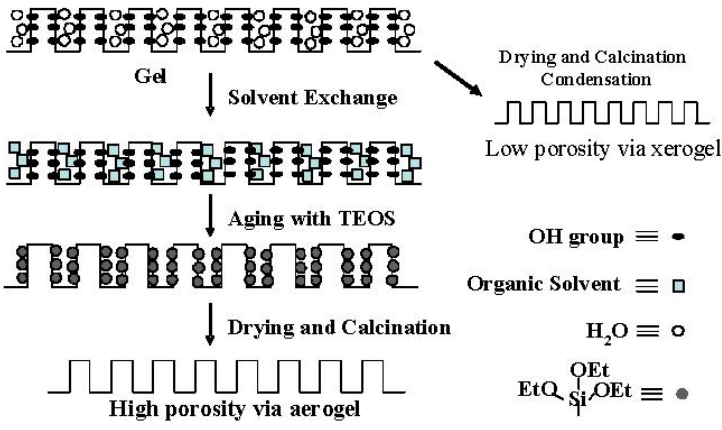
Figure 4. Conceptual scheme of the gel skeletal reinforcement.